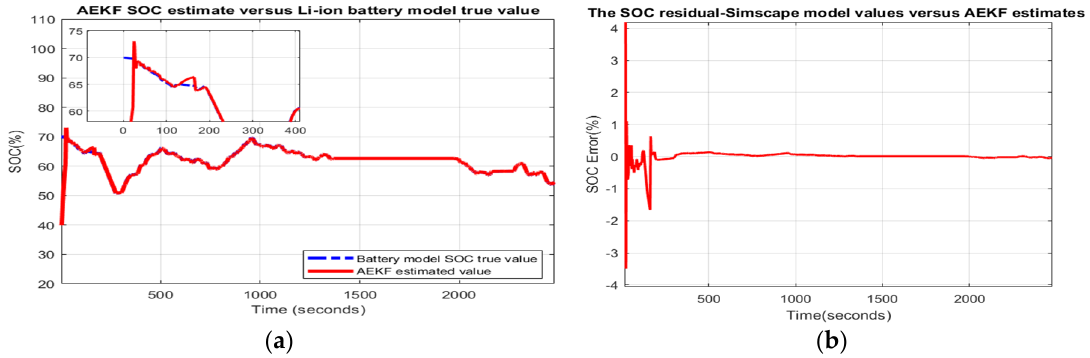
Figure A16. Robustness to changes in SOC initial value—SOCini = 0.4. ( a )AEKF SOC estimate versus battery SOC true value; ( b ) SOC residual.